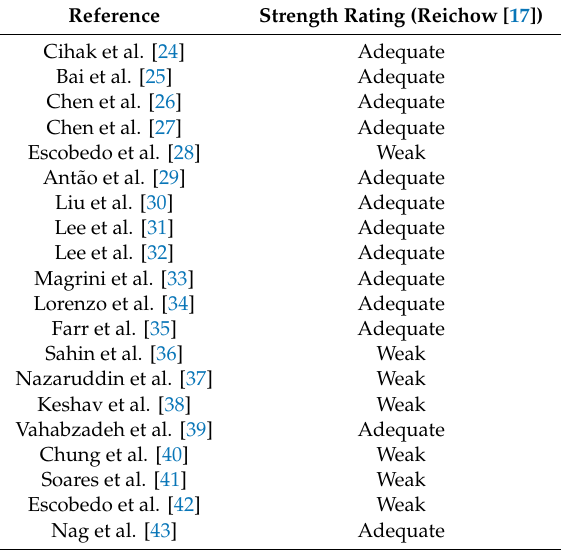
Table 3. Summary of the strengths of each